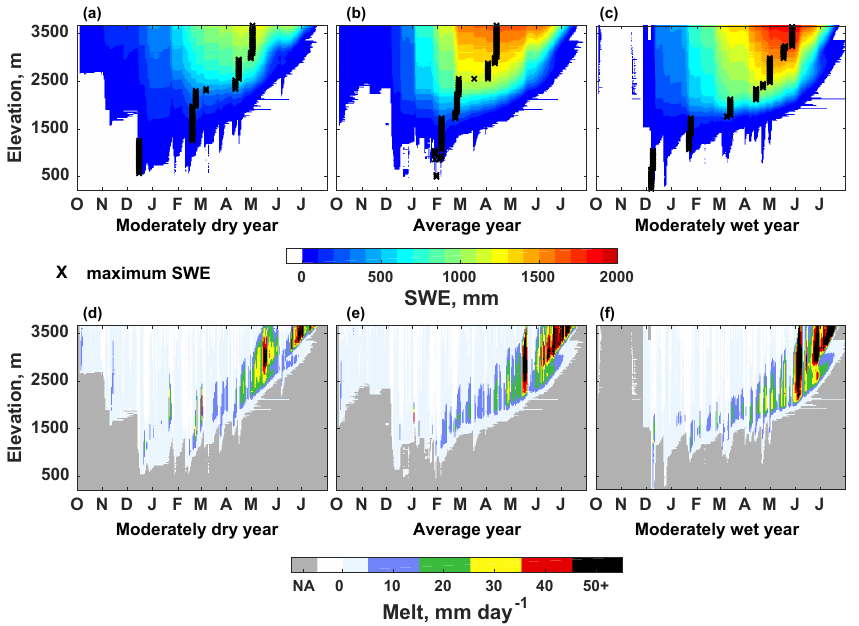
Figure 5. Distribution of (a, b, c) SWE and (bottom panels) daily melt by elevation (mean values within 18m elevation bins; y axes) and time (daily; x axes) for a moderately dry (2009; a, d ), near-average (2008; b, e ), and moderately wet (2010; c, f ) snow season. The grey color in the lower panels indicates times when there is no snow to melt (NA). The elevation-specific dates of maximum SWE are indicated.